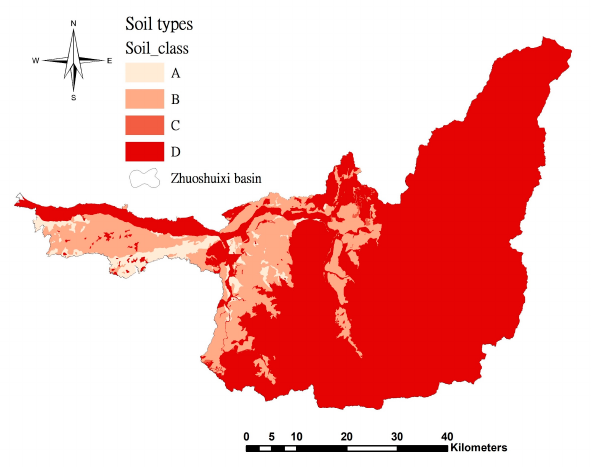
Figure 8. ( a ) Flooding risk map (100-year return period) and ( b ) a risk level map based on subdivisions.